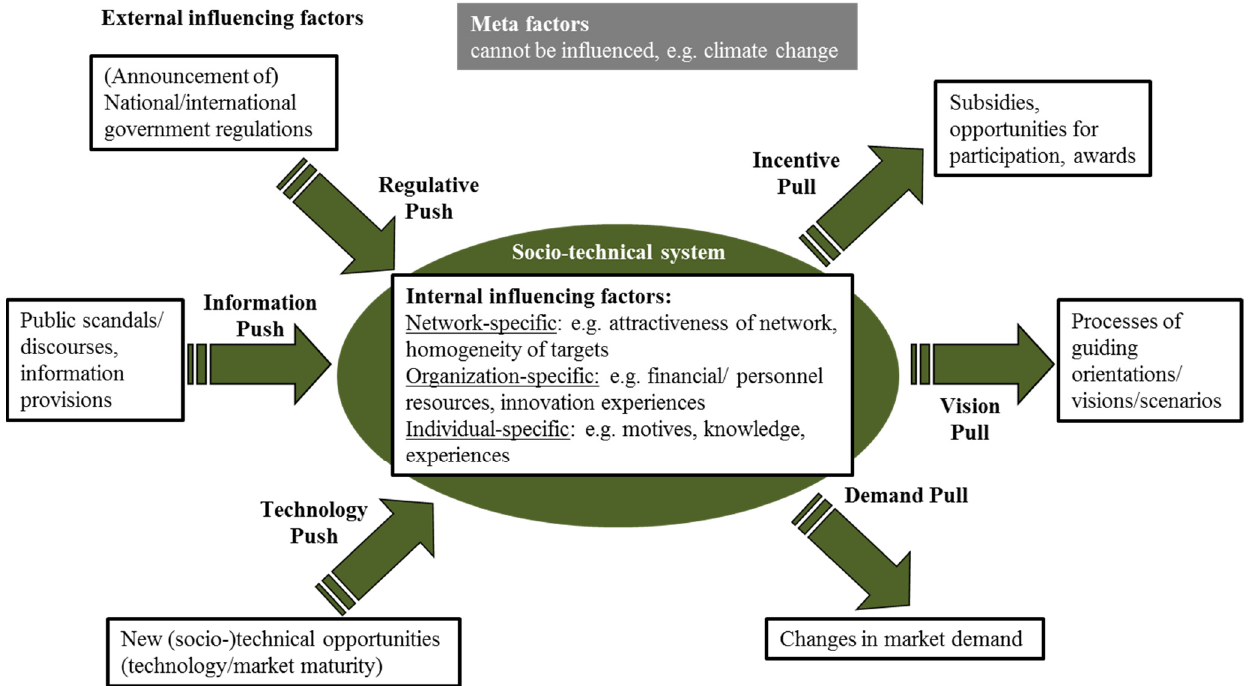
Figure 1. Filled turtles model of socio-technical systems based on